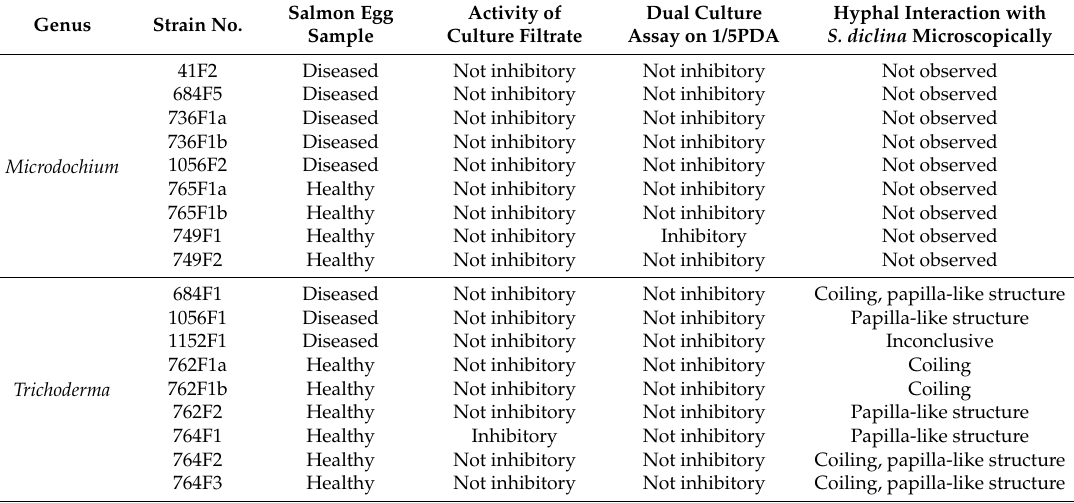
Table 1. In vitro activity of Microdochium or Trichoderma isolates against hyphal growth of Saprolegnia diclina 1152F4. The fungal isolates were retrieved from Saprolegnia -infected (diseased) or healthy salmon egg